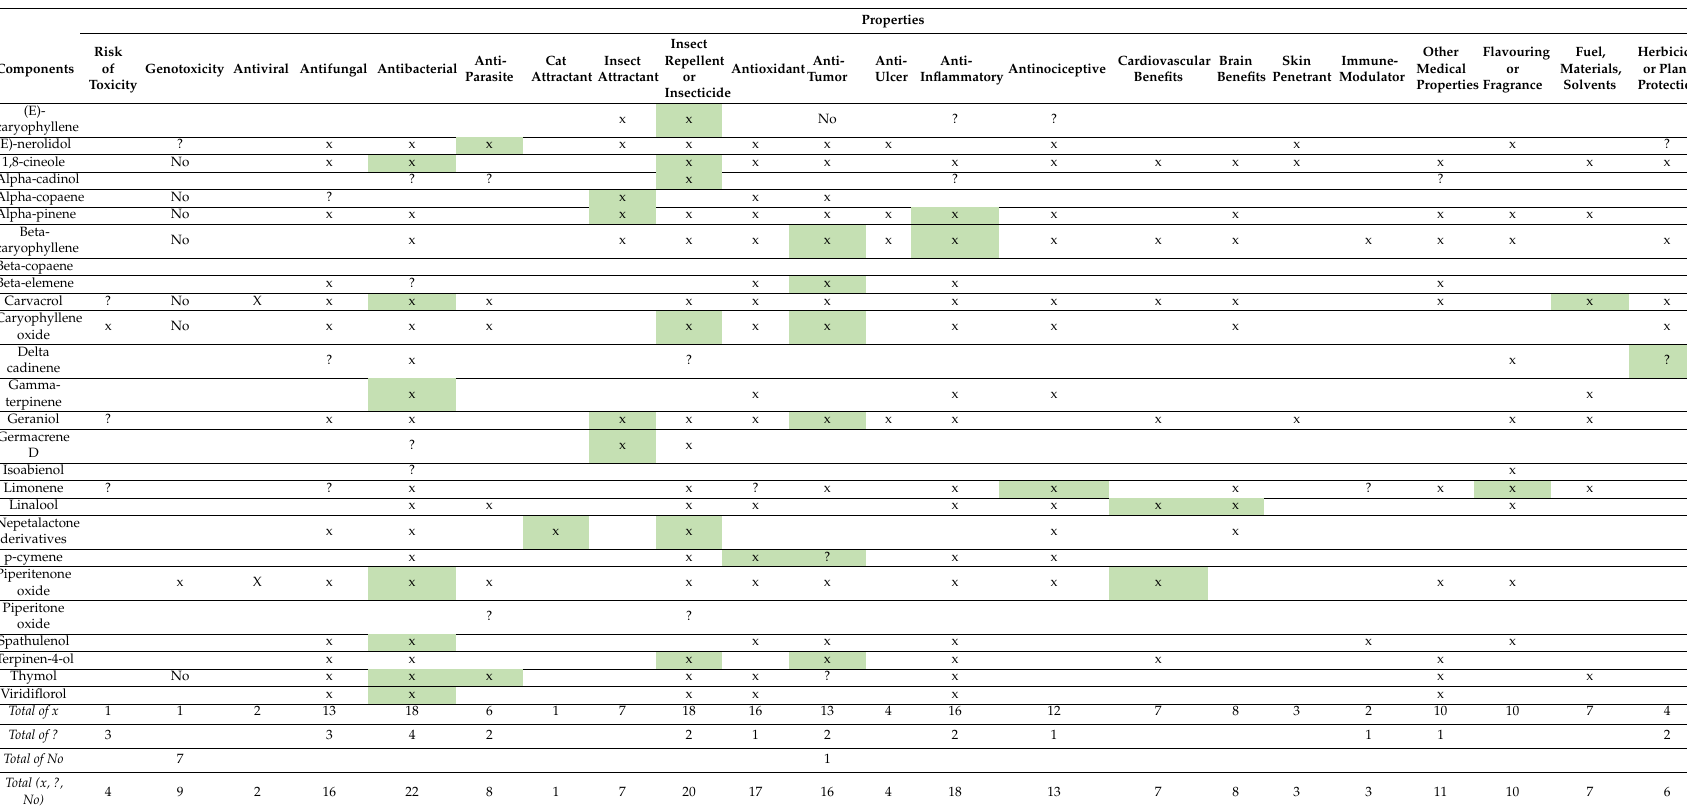
Table 2. Correspondence matrix among components and properties. x = proved property; ? = suspected or weak property; No = property proved to be absent; green cells = most investigated property for that